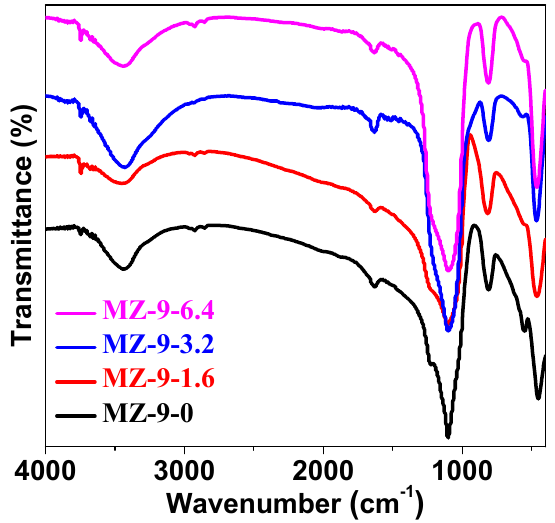
Figure 7. FT ‐ IR spectra of MZ ‐ 9 ‐ 0, MZ ‐ 9 ‐ 1.6, MZ ‐ 9 ‐ 3.2, and MZ ‐ 9 ‐ 6.4. Figure 7. FT-IR spectra of MZ-9-0, MZ-9-1.6, MZ-9-3.2, and